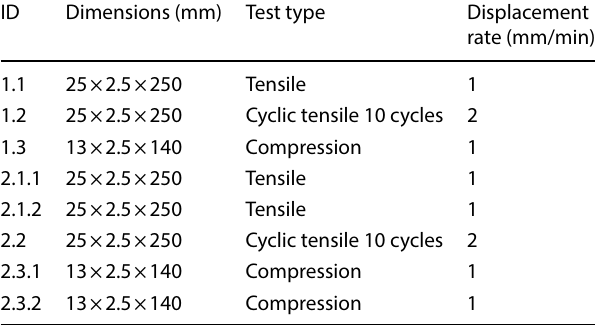
Table 2 Testing scenarios for the composite coupons ID Dimensions (mm) Test